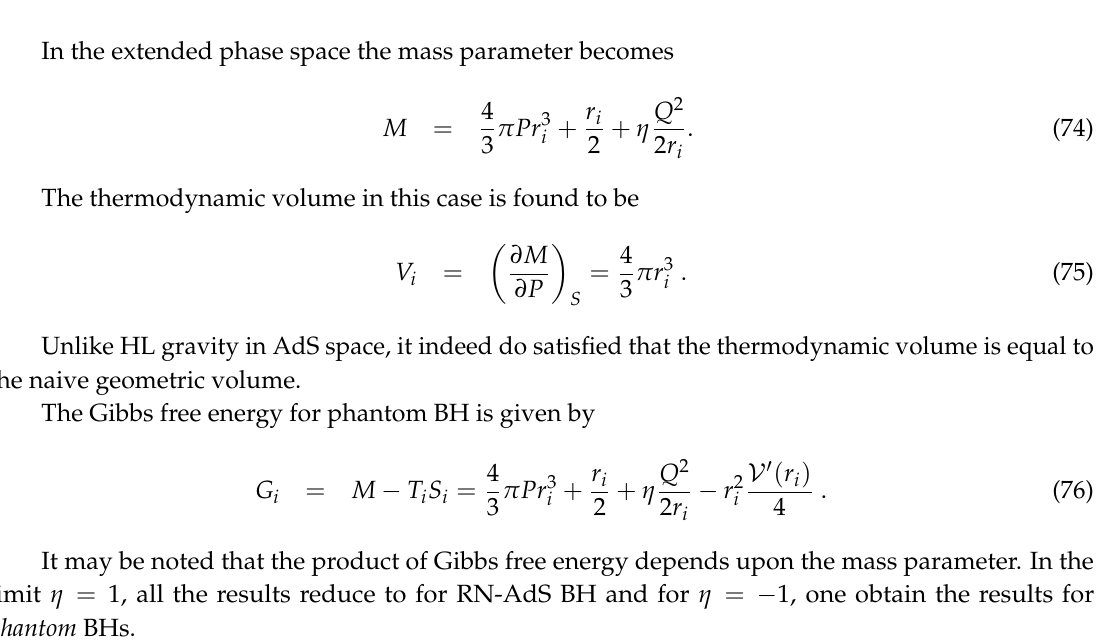
Figure 2. In this figure, we have plotted the variation of specific heat with horizon radius for phantom AdS BH. Here η = − 1, (cid:96) = 1 and x = r +